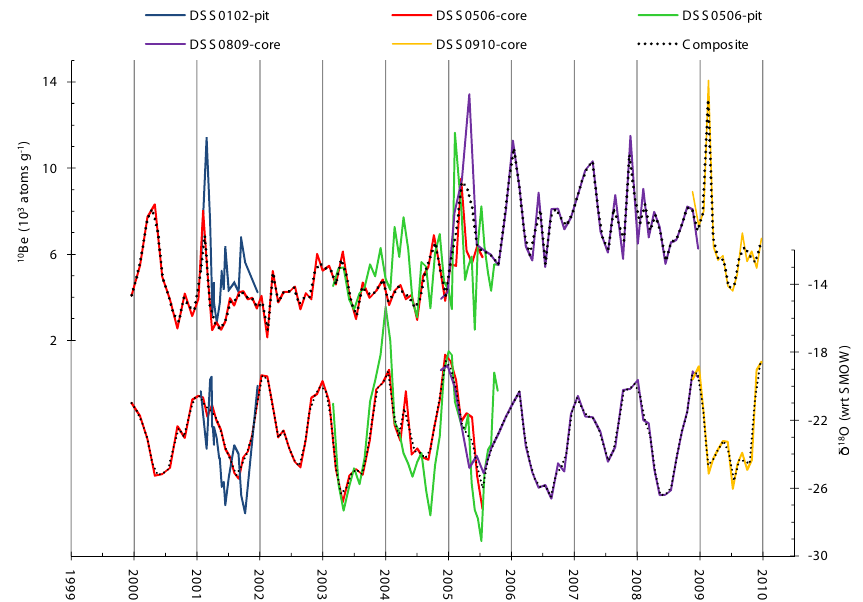
Fig. 3. (a) 10 Be concentrations and (b) δ 18 O ratios in three new high-resolution ice core records from DSS, Law Dome (DSS0506-core, DSS0809-core and DSS0910-core), and also in two previously published (Pedro et al., 2006, 2009) snow pits (DSS0102-pit and DSS0506- pit). Composite records constructed (see Sect. 3.3) from the ice core series are overlain, providing a 10-yr (1999 to 2009) monthly-resolved record of 10 Be concentrations and δ 18 O ratios at DSS. Timescale uncertainty is estimated at ± ( 1 to 2 ) months, standard 10 Be measurement errors are generally <